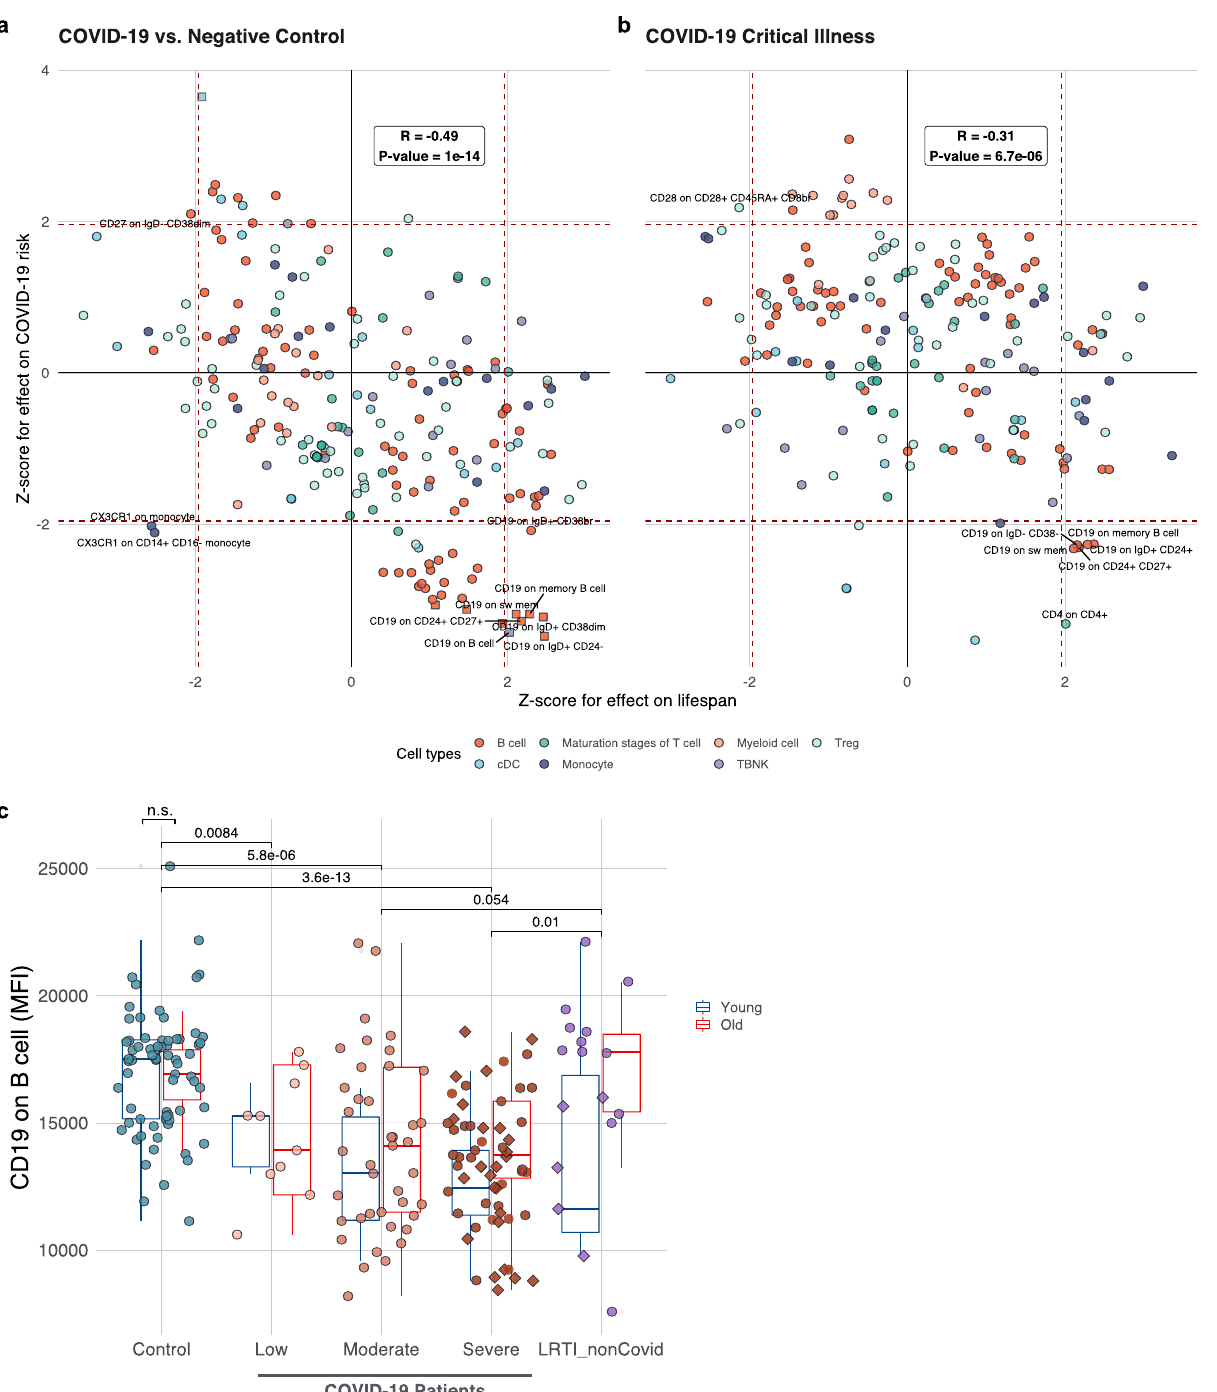
Fig. 4 Mendelian randomization on 389 immune cell-type-speci fi c surface markers and analysis of clinical data reveal the role of CD19 in B cells. Mendelian randomization results showing the effect of immune cell surface marker levels on lifespan ( x -axis), and the y -axis shows the Z -score for the risk of COVID-19 infection ( N trait = 389) ( a ) and COVID-19 critical illness ( b ). Red dashed lines to denote the ±1.96 Z -score threshold (equivalent to P < 0.05). Only traits with P < 0.05 for both outcomes are annotated. Traits with FDR < 0.05 for at least one outcome are shown in squares. c Box plot showing the CD19 level in B cells in different groups ( N control = 70, N low = 10, N moderate = 41, N severe = 58, N LRT = 17). Blue boxes represent younger subjects (age < 60) and the red boxes older subjects (age > 60). Subjects that have been admitted to ICU are in the diamond. The center line in the box shows the median. The bottom and top of the box show the 25th and 75th quantiles. The whiskers represent the expected variation of the data. The whiskers extend 1.5 times the IQR from the top and bottom of the box. cDC classical dendritic cells, TBNK T cells B cells and natural killer cells, MFI median fl uorescence intensities, LRT lower respiratory tract